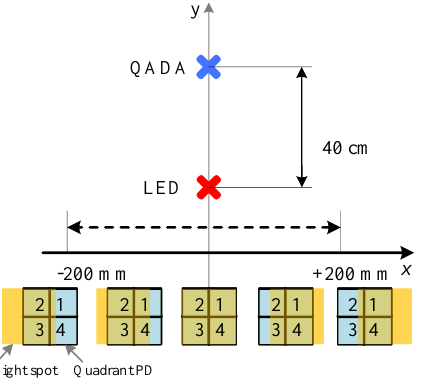
Figure 15. Experiment set-up diagram and the overlap between the light spot and the quadrant PD as the transmitter moves along the x